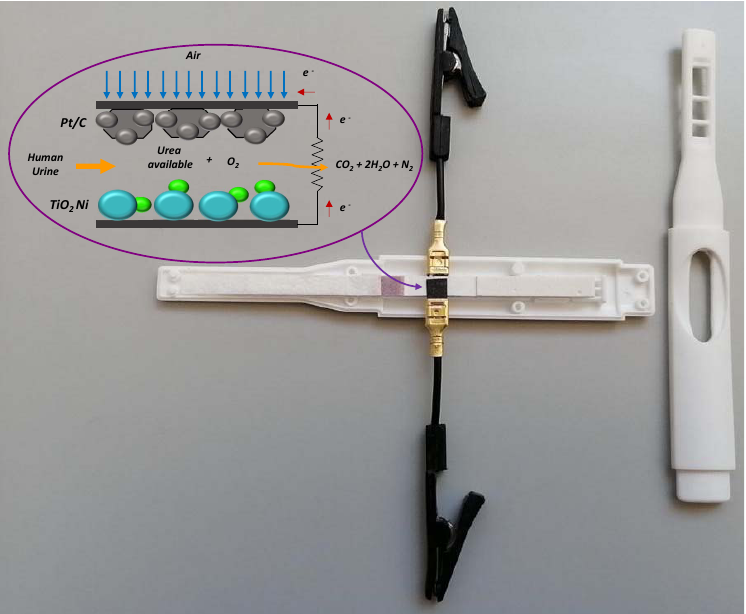
Figure 1. Photograph and schematic design of the qualitative pregnancy test used as a support for an air-breathing paper-based microfluidic fuel